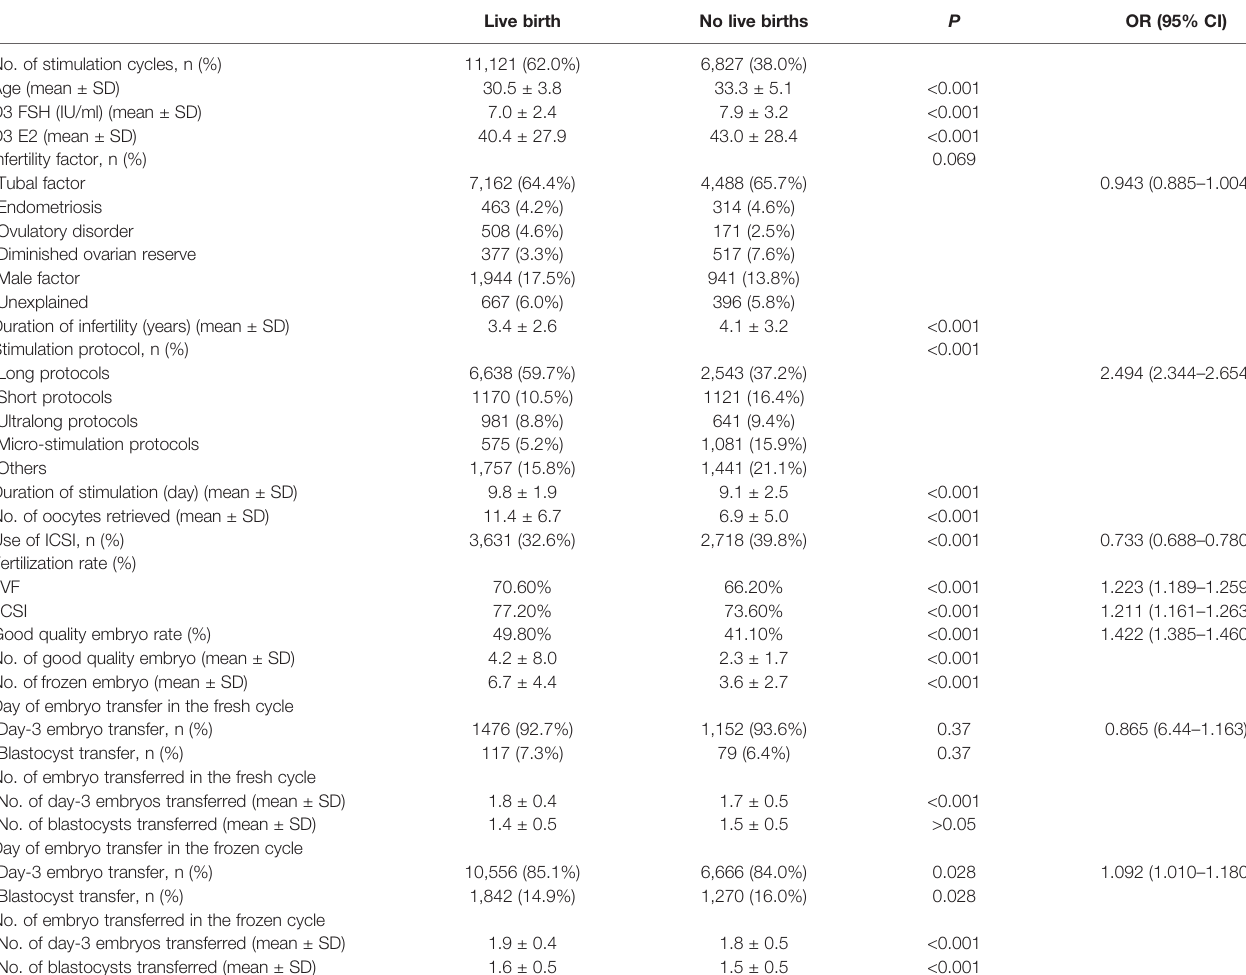
TABLE 1 | Basal characteristics and fresh/FET IVF/ICSI outcomes.